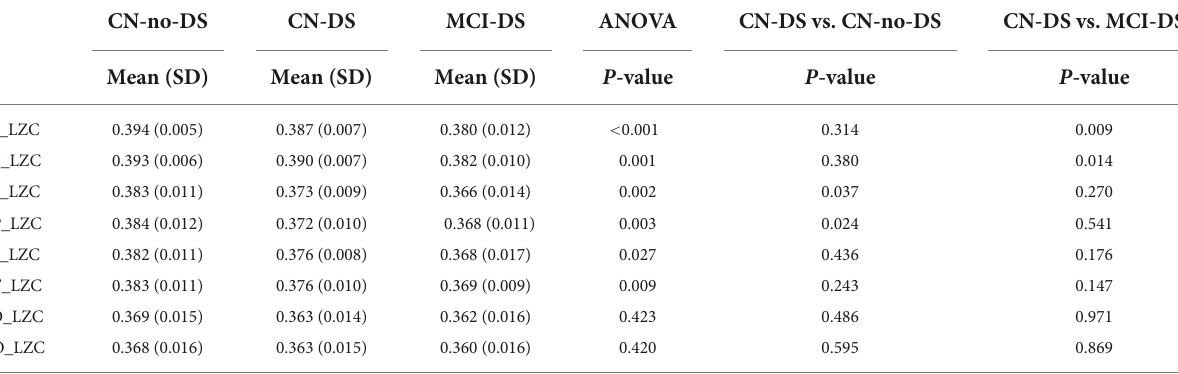
TABLE 2 LZC values across groups and